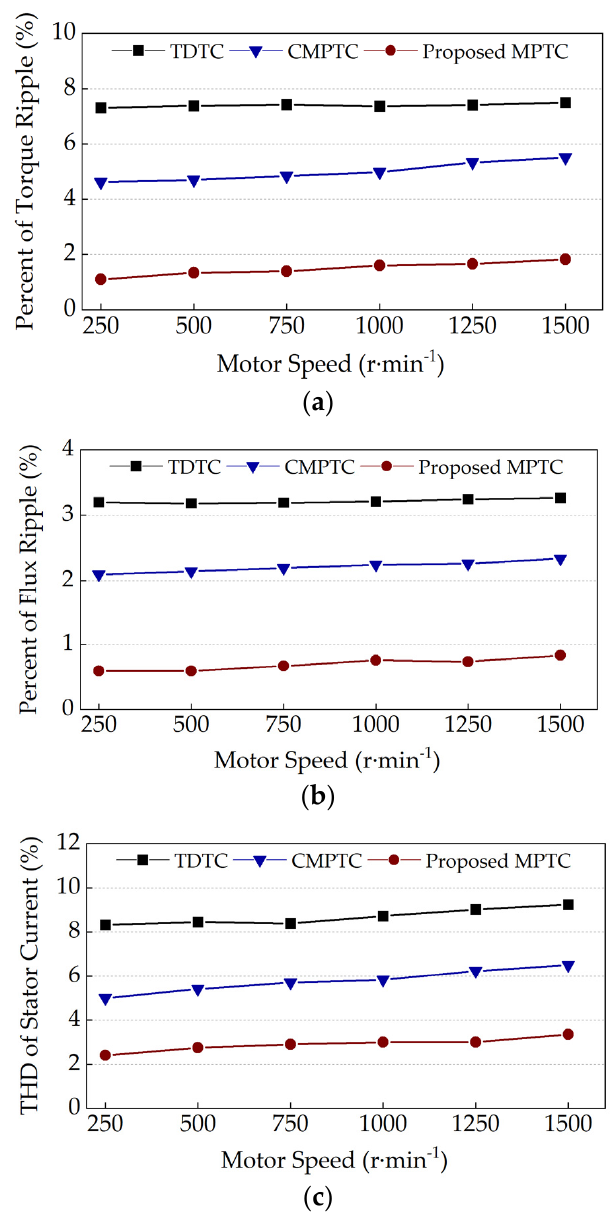
Figure 13. Comparison of the steady-state performance for the three methods at various speeds with a constant 5 N·m load: ( a ) torque ripple percentage, ( b ) flux ripple percentage, and ( c ) stator current THD.